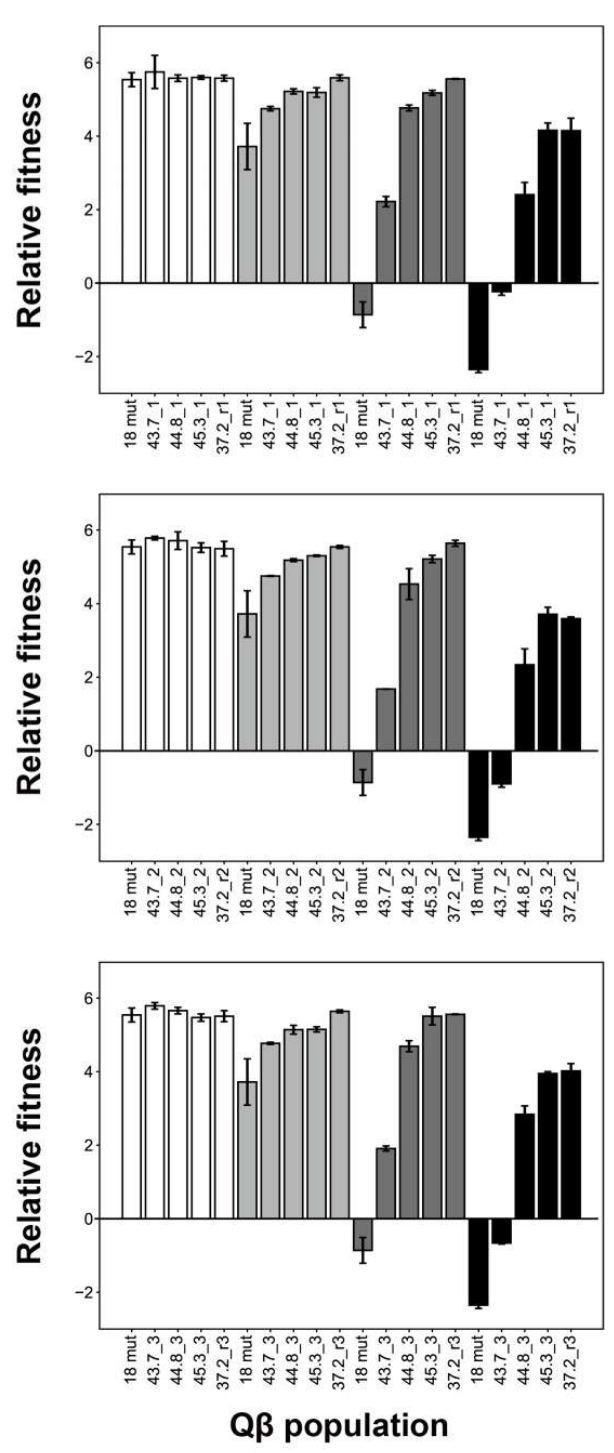
Figure 3. Relative fitness of Qβ 18 mut and populations that evolved under conditions of elevated temperature. Relative fitness was measured at 37.2 °C, 43.7 °C, 44.8 °C, and 45.3 °C for the Qβ 18 mut and endpoint 43.7 °C-, 44.8 °C-, 45.3 °C-, and 37.2 °C-adapted populations. Upper, middle, and lower frames demonstrate the relative fitness of lines 1, 2, and 3, respectively. Data are presented as means ± standard deviations ( n = 2–14).